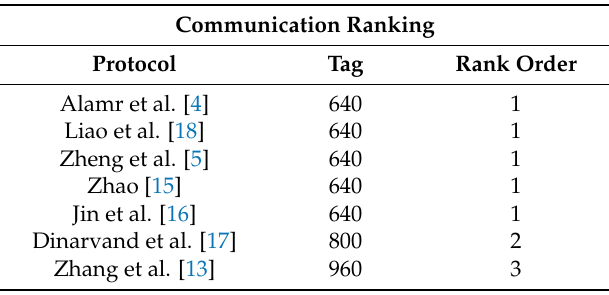
Table 8. Ranking based on tag to reader/server communication